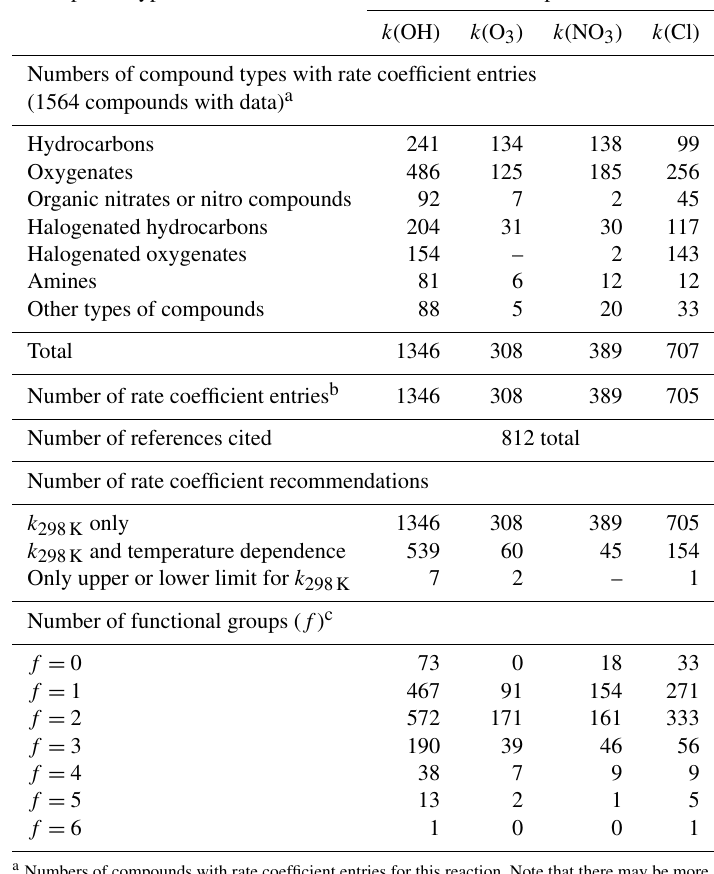
Table 1. Summary of current contents of the experimental atmospheric rate coefficient database for VOCs. Compound